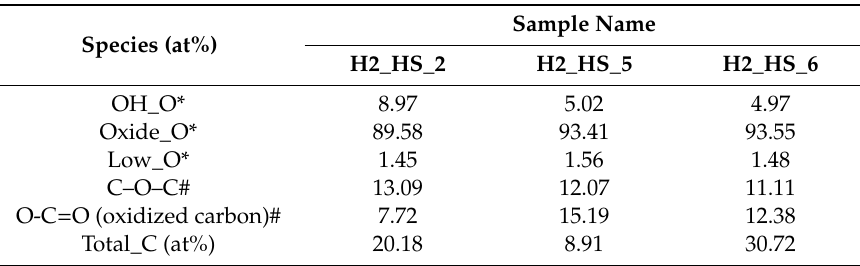
Table 3. The amounts of di ff erent oxygen- and carbon containing species in samples H2_HS_2, H2_HS_5, and H2_HS_6. * From the total amount of O; # From the total amount of C. Species